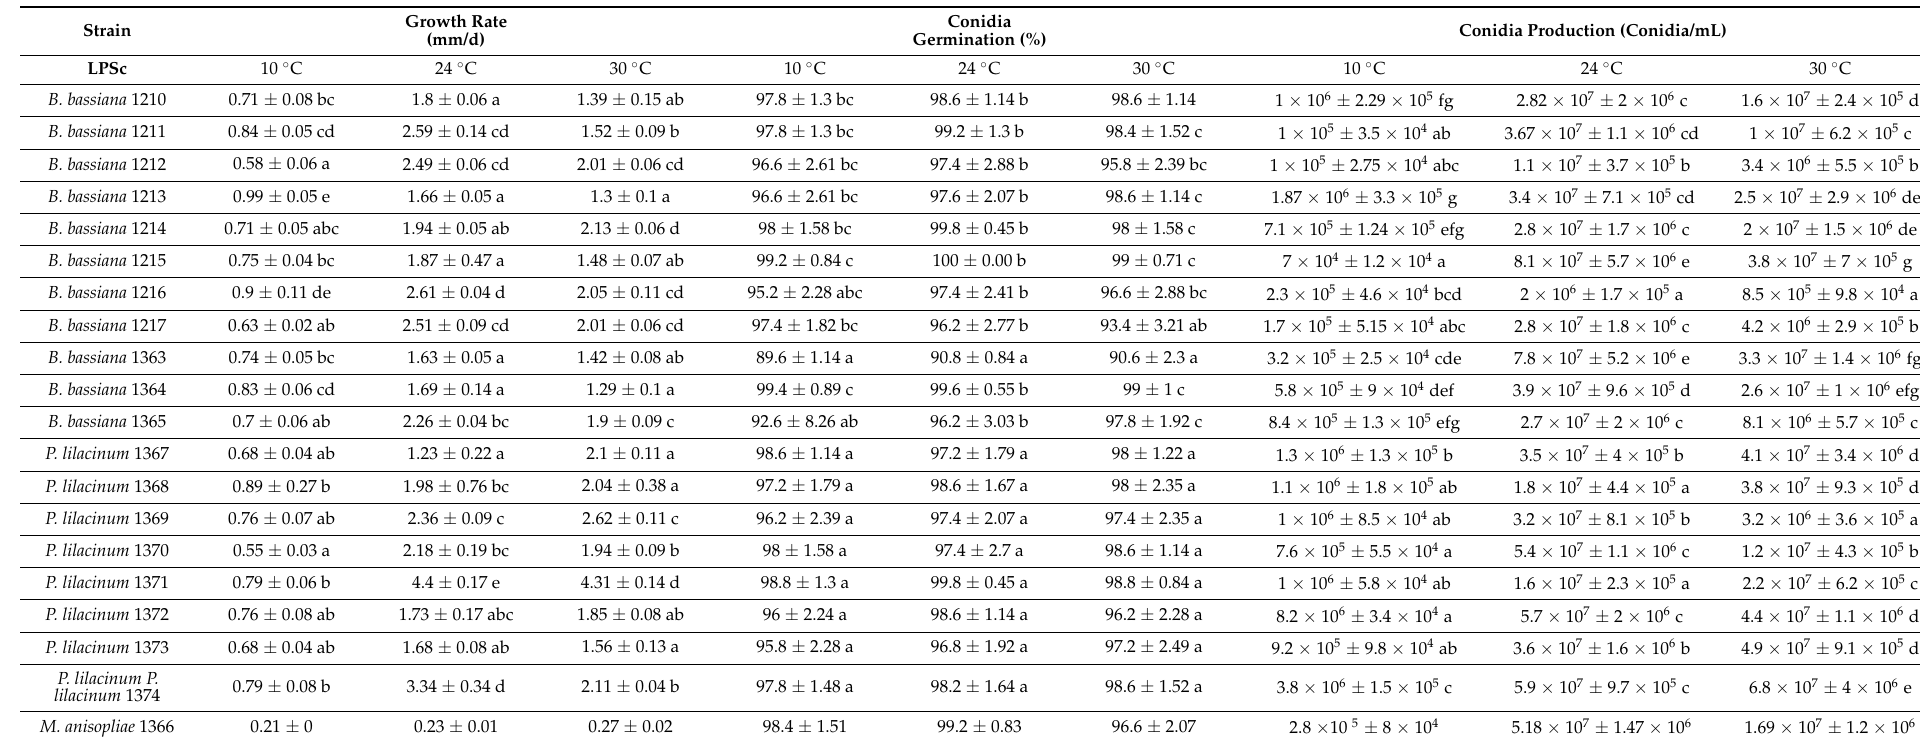
Table 2. Strain growth rates, conidia production and germination at 10, 24 and 30 ◦ C. Different letters among isolates of the same species (same row) indicate significant differences according to Tukey’s test ( p <